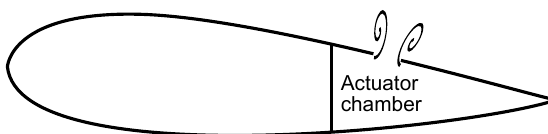
Figure 4. Simplified schematic view of a vortex generator